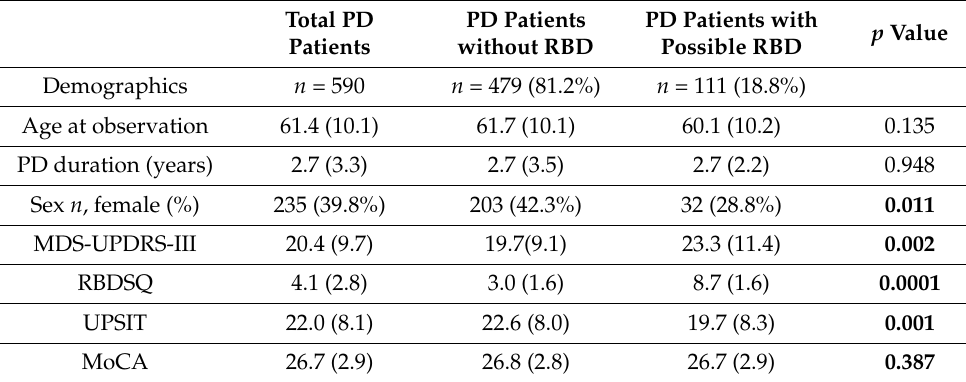
Table 1. Demographic and clinical information of PD